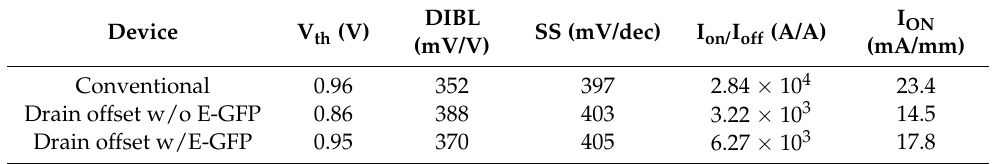
Table 2. Electrical parameters of the JL FinTFTs with various